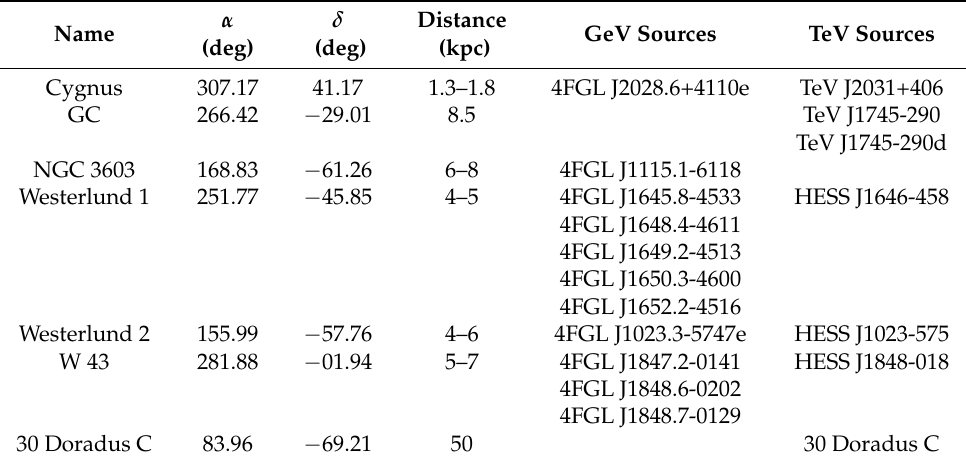
Table 2. List of the most prominent star-forming regions with established or potential detections in gamma